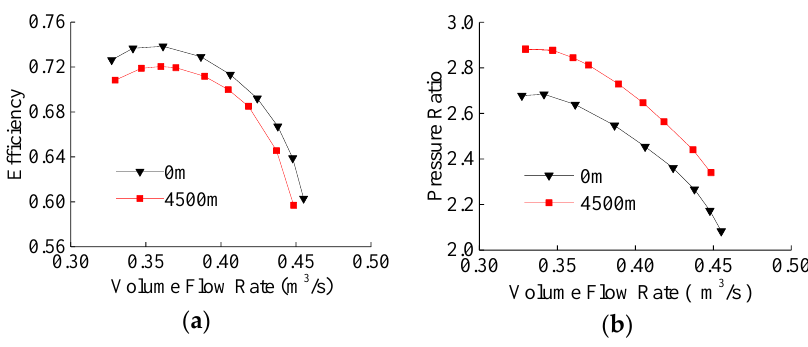
Figure 5. Characteristics of compressor volume flow rate, pressure ratio and efficiency: ( a ) Efficiency characteristics; ( b ) Pressure ratio characteristics.